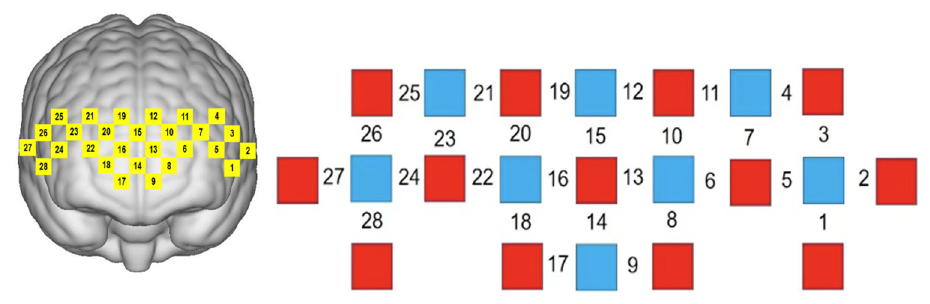
Figure 2. Portable fNIRS device wearing and channel layout. The yellow numbers on the left represent the corresponding detection positions of the photopolar cap in the prefrontal cortical area, the red squares on the right indicate the emitter (light source), the blue squares indicate the detector (probe), and the black numbers indicate the established channels. Table 2. Correspondence table between channel layout and brain regions of portable fNIRS devices. Brain Regions